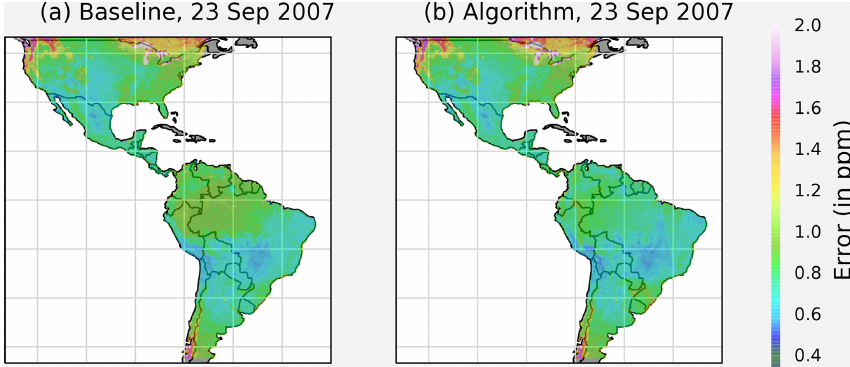
Figure 9. Comparison of the spatial distribution of XCO 2 errors of the baseline strategy (a) and the algorithm-selected strategy (b) .